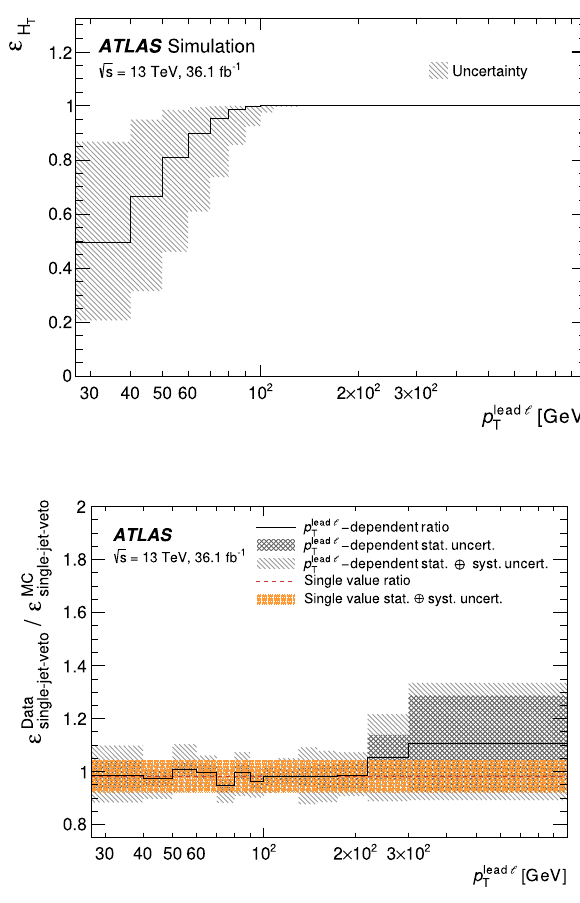
/(cid:14) MC efficiency ratio (cid:14) Data . The latter is constant within single-jet-veto single-jet-veto uncertainties, and therefore replaced by the inclusive efficiency ratio (dashed line). In all figures, statistical and systematic uncertainties are displayed as hatched , (lower T , and (lower right) the jet-veto